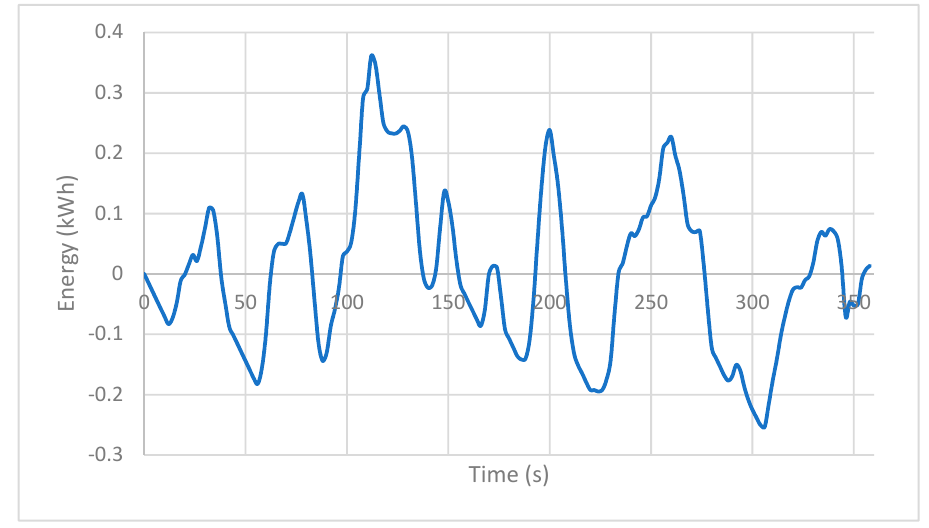
Figure 8. Cumulative energy required from the SC throughout the peak power profile.